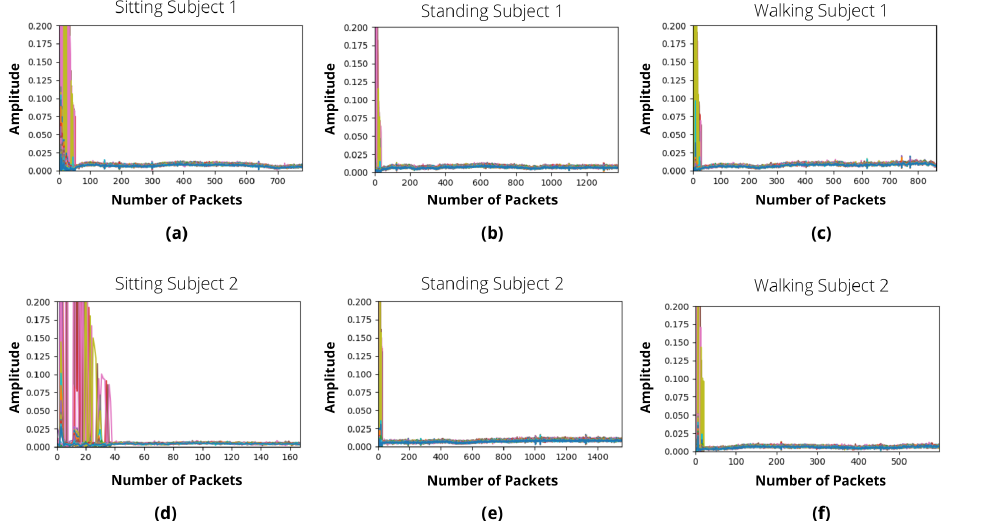
Figure 6. IRS-OFF activities samples in form of CSI in a multi-floor scenario. ( a ) Person 1 sitting. ( b ) Person 1 standing. ( c ) Person 1 walking. ( d ) Person 2 sitting. ( e ) Person 2 standing. ( f ) Person 2